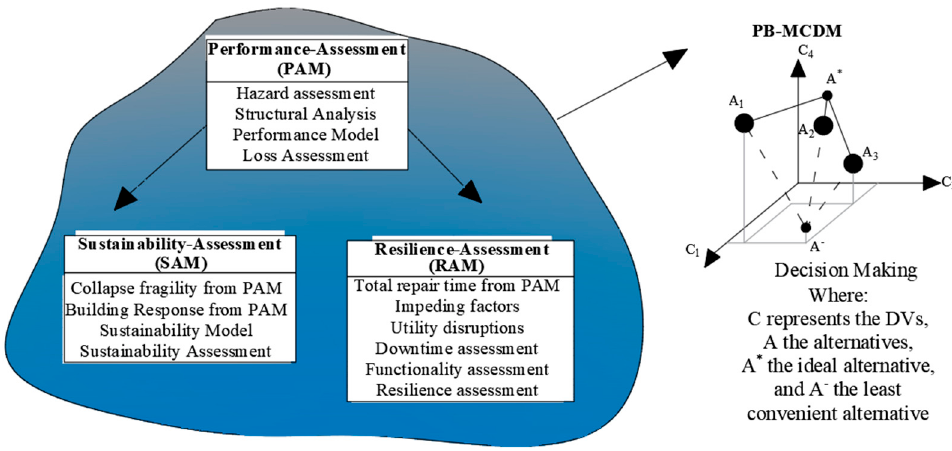
Figure 6. Main modules of the proposed framework for PB–MCDM, adapted from [49].